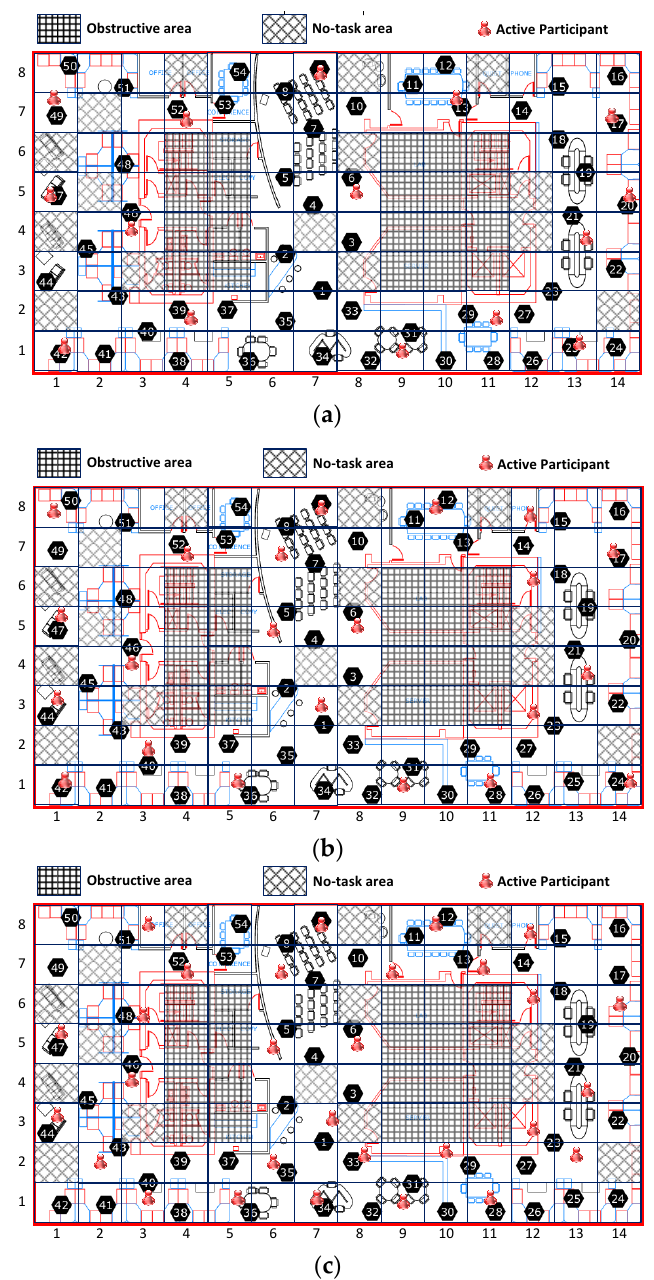
Figure 8. Active participants’ distribution by IPSA, RS, and LDS. ( a ) IPSA; ( b ) RS; ( c ) LDS.